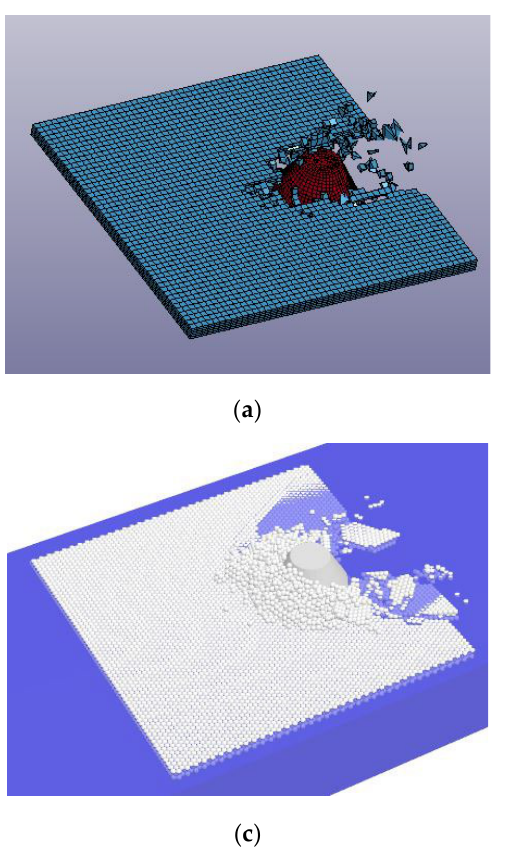
Figure 5. Simulation of interaction between cylinder structure and level ice. ( a ) Schematic diagram of finite element method calculation; ( b ) top view of finite element method calculation; ( c ) schematic diagram of discrete element method calculation; ( d ) top view of discrete element method calcula- tion.